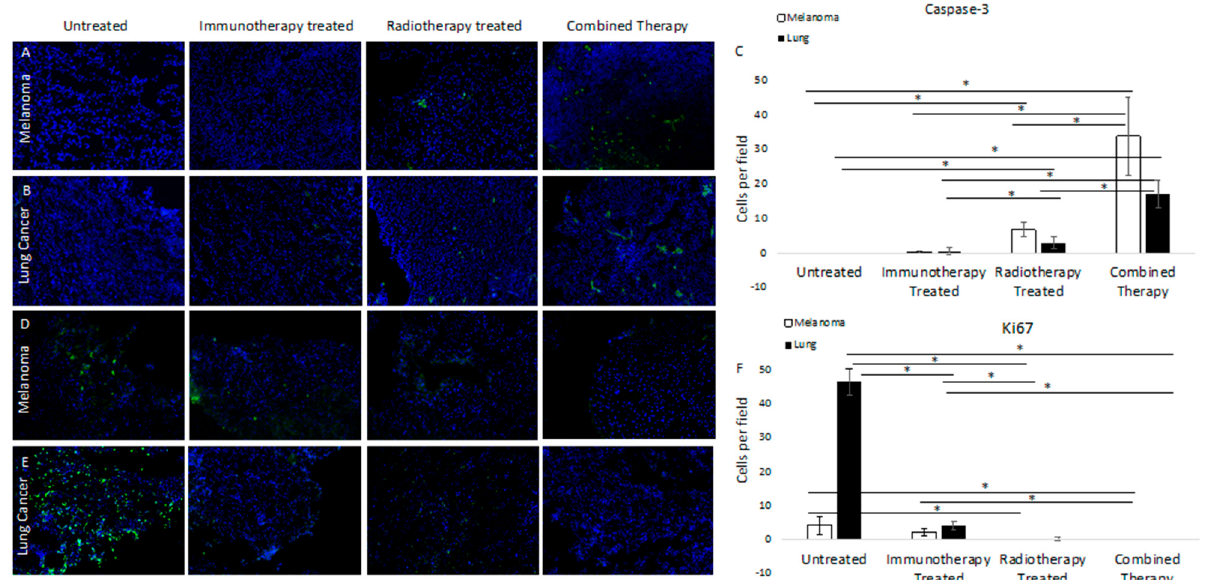
Figure 2. Immunofluorescence staining of untreated and treated tumors for caspase-3 in melanoma ( A ) and lung cancer ( B ) demonstrated increased staining in samples treated with either immunotherapy or FAP-targeted radiotherapy, with markedly increased caspase-3 activity in tumors treated with both. ( C ) Quantifies positive cells per field and demonstrates significantly increased caspase-3 staining for the combined therapy group compared to untreated, immunotherapy, or radiotherapy treated samples ( p = 0.001, 0.003, and 0.001 for melanoma and p = 0.0002, 0.0007, and 0.002 for lung cancer, respectively). Conversely, staining for Ki67 in melanoma ( D ) and lung cancer ( E ) demonstrated significant differences in staining of untreated samples, with decreased staining in samples treated with either therapy and essentially no Ki67 staining in tumors treated with dual therapy. ( F ) demonstrates quantification of positive cells per field and significantly decreased staining for the combined therapy group compared with untreated and immunotherapy- treated samples ( p = 0.02, 0.003, respectively). For lung cancer, there were significant differences in Ki67 staining in the combined therapy group compared with untreated and immunotherapy-treated samples ( p = 0.0000007 and 0.0005, respectively). Significant differences are marked with a line with an